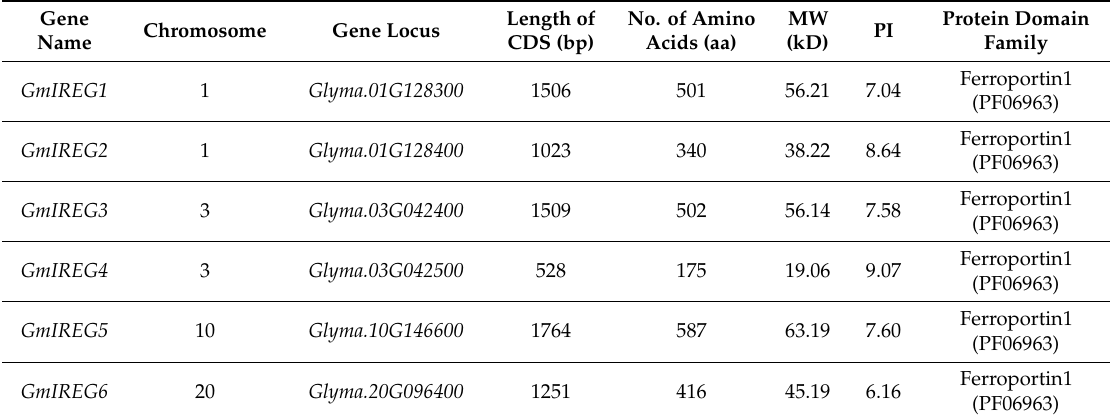
Table 1. Summary of IREG family genes in soybean.